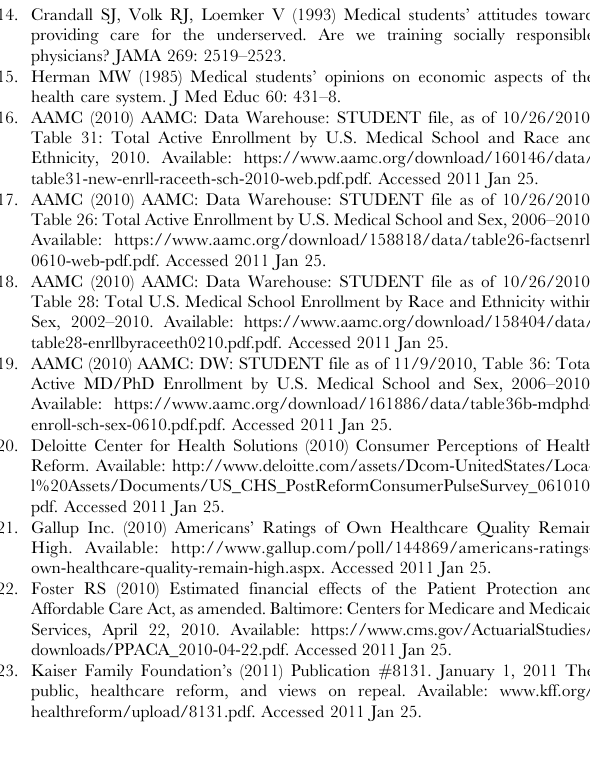
Table S6 1Participants were given a choice of five pre-formed